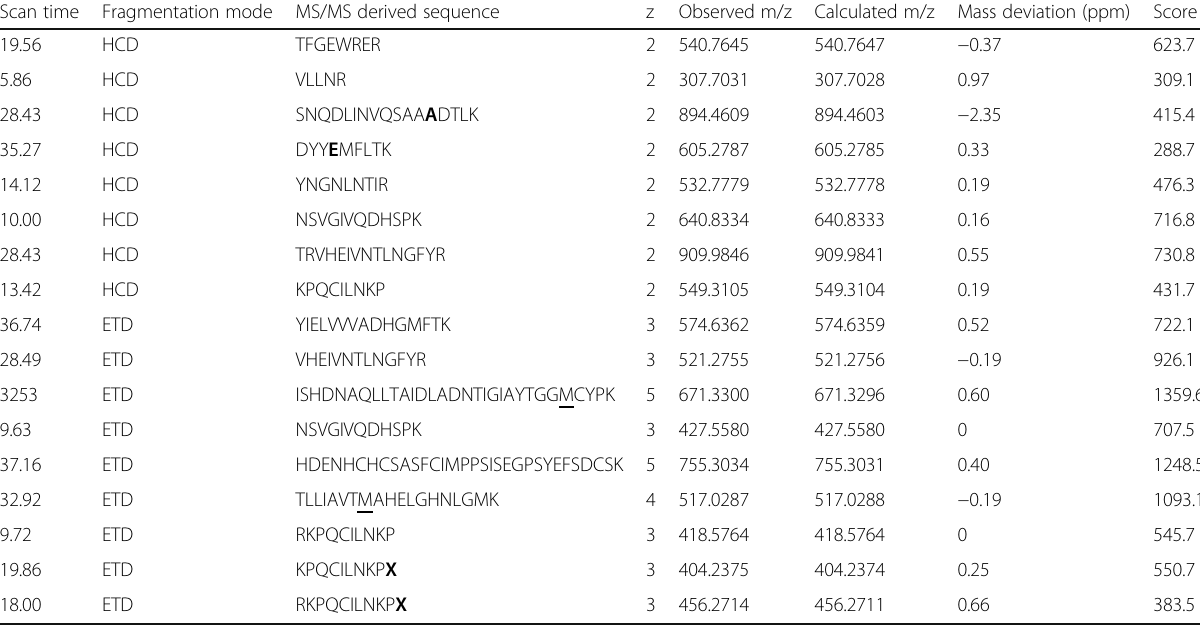
Table 1 Tryptic peptides identified through MS/MS analysis Scan time Fragmentation mode MS/MS derived